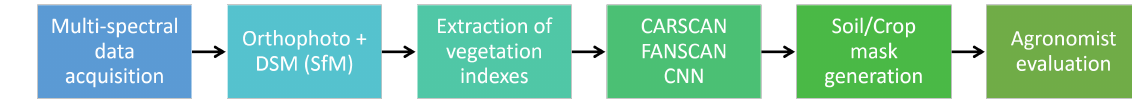
Figure 1. Workflow to process multi-spectral images; crop/soil segmentation enables the generation of masks that will be considered by the agronomist to exclude areas out of